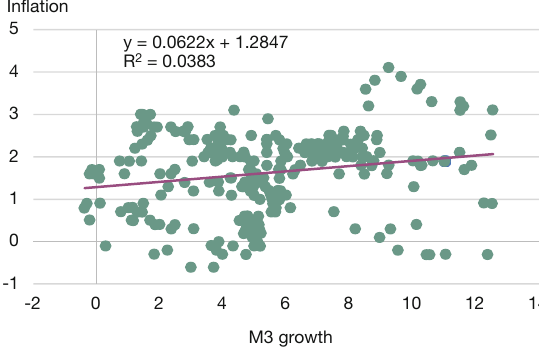
Figure 2 Infl ation and M3 growth in the eurozone,